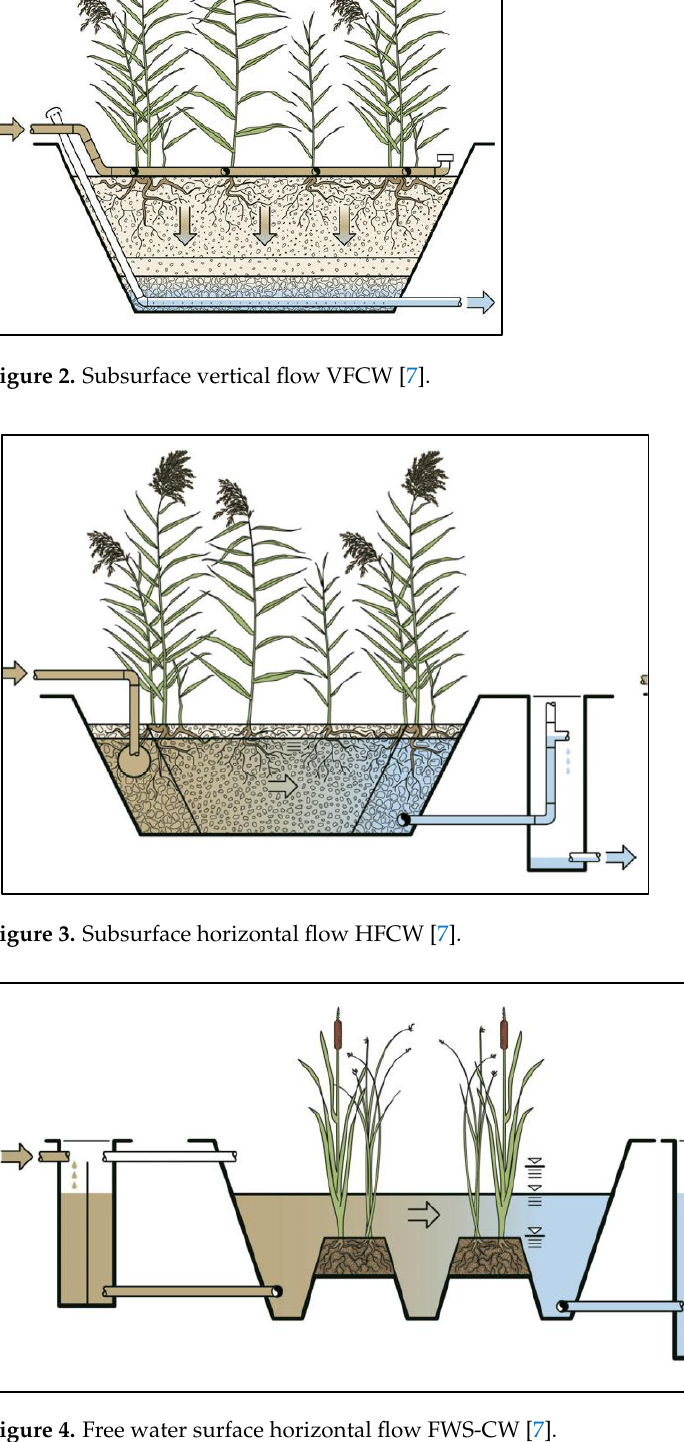
Figure 4. Free water surface horizontal flow FWS-CW [7]